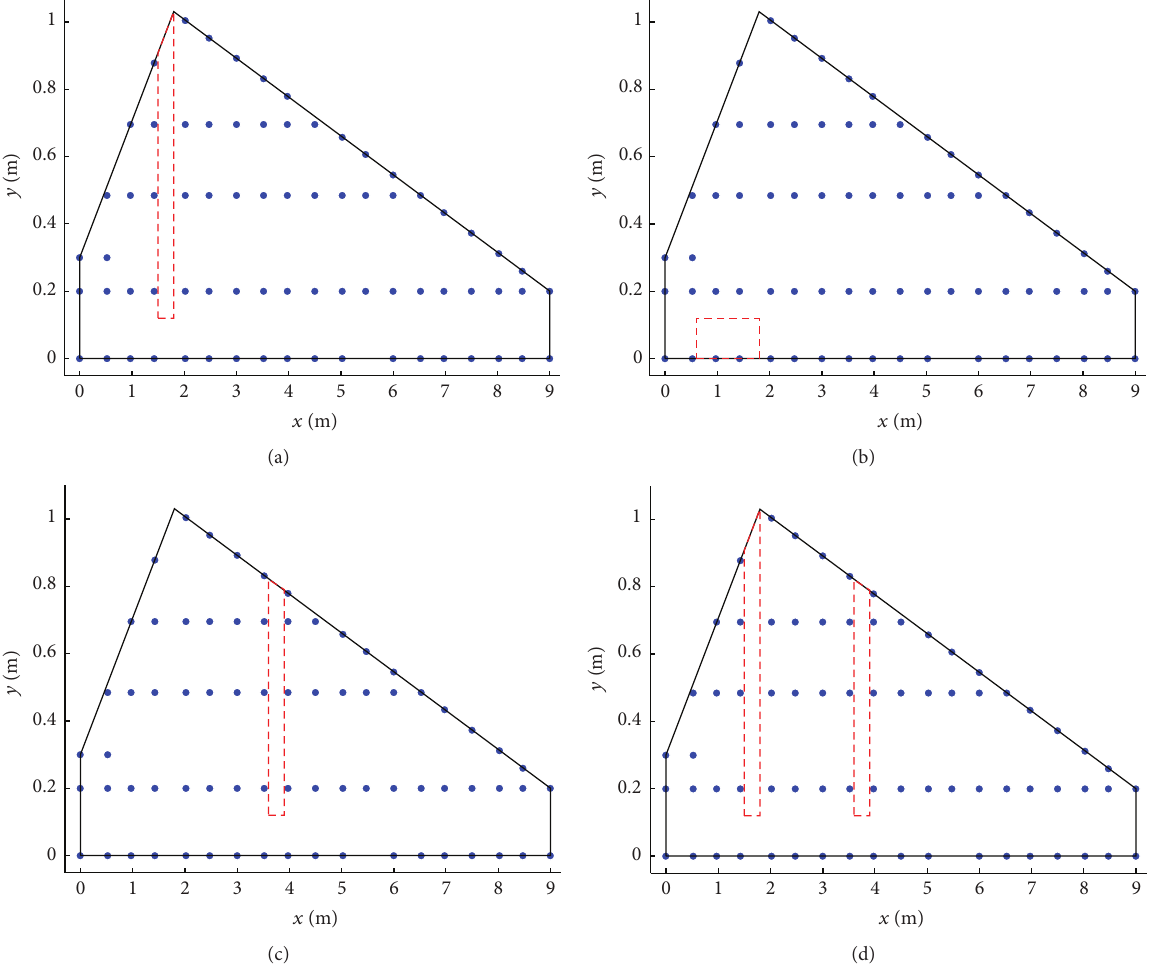
Figure 6: Damage locations under study: (a) location 1, (b) location 2, (c) location 3, and (d) location